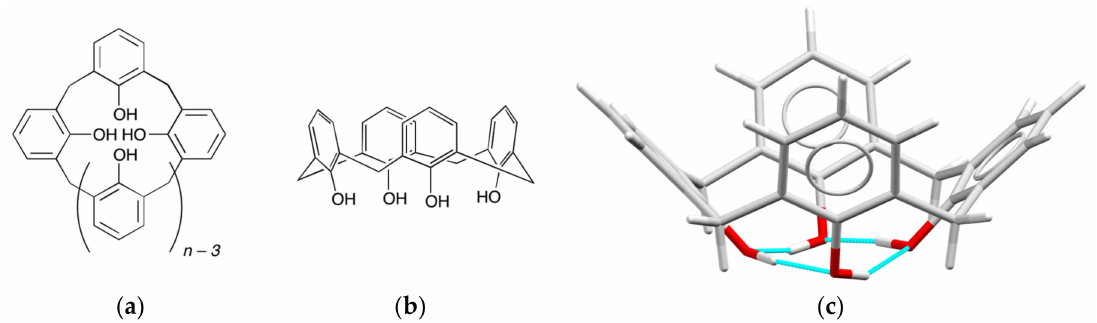
Figure 1. ( a ) Structure of calix[ n ]arene; ( b ) Three dimensional representation of the calix[4]arene in the cone conformation; ( c ) A representation of a structurally characterised calix[4]arene in the cone conformation [10], highlighting the hydrogen bonds (in blue) between the phenol O